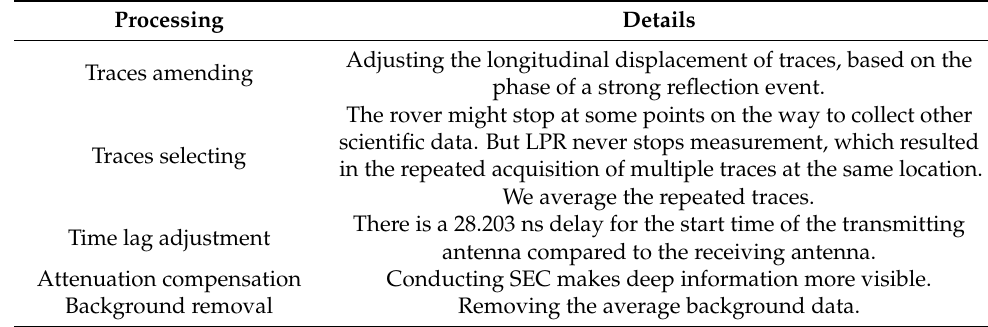
Table A1. Data processing procedures before